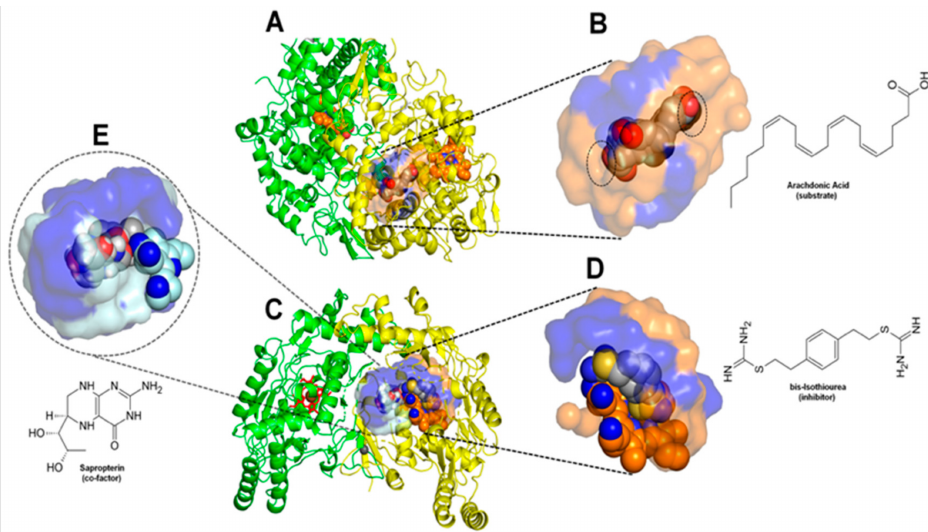
Figure 1. Physical-chemical characteristics for each docking site and their complementarity to the respective higher affinity controls. ( A )—Full vision of the COX-1 with their two monomers (cartoons in green and yellow ), cofactors (spheres and sticks) and the docked active site in surface and spheres. ( B )—inlet vision of the same active site containing the crystallographic and the three first docking poses of the more positive control (substrate arachidonic acid represented in spheres, colored in grey and red for carbons and oxygens, respectively), as well its skeletal formula. The polar residues at the active site (a.s.) surface are shown in blue , while the nonpolar in orange . Dashed circles show the two a.s. entrances. ( C )—Similar full vision of the two monomers from iNOS. ( D )—Inlet of the iNOS active site (iNOSas) containing the more positive control bis-isothiourea (competitive inhibitor). Colors and schemes similar to B, with the heme group from the a.s. also shown in spheres, as well the ligand’s sulfurs and nitrogens, respectively in yellow and blue . ( E )—inlet of the iNOS cofactor site (iNOScs) containing the more positive control sapropterin (cofactor). Colors and schemes similar to D, but with the nonpolar regions of the cofactor site (c.s.) in silver